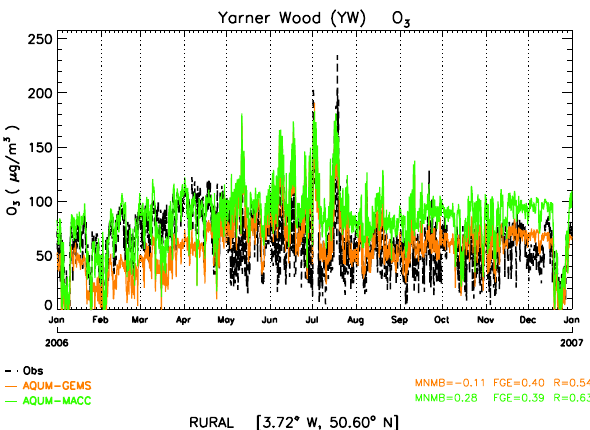
Fig. 16. Time series of ozone at the rural site Harwell comparing AQUM-GEMS, EU-GEMS and EUUK-GEMS model configura- tions for 2 June to 29 July